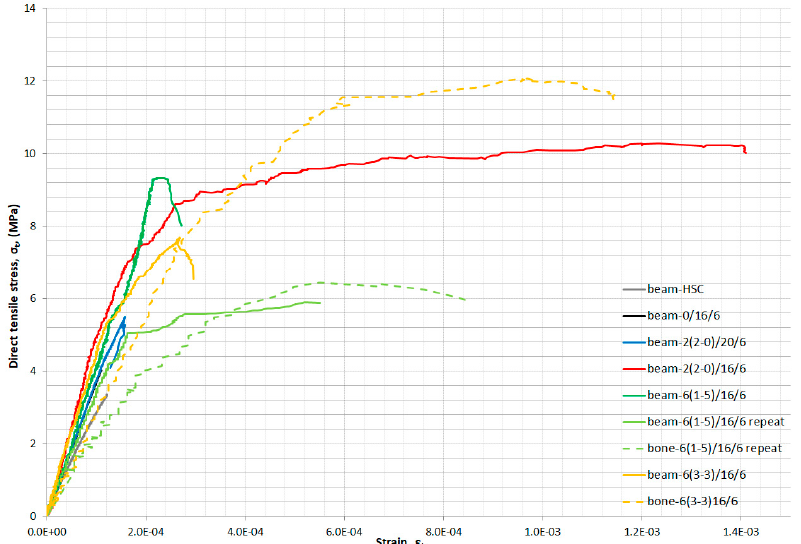
Figure 9. Compressive stress–strain curves from cylinder compression test.